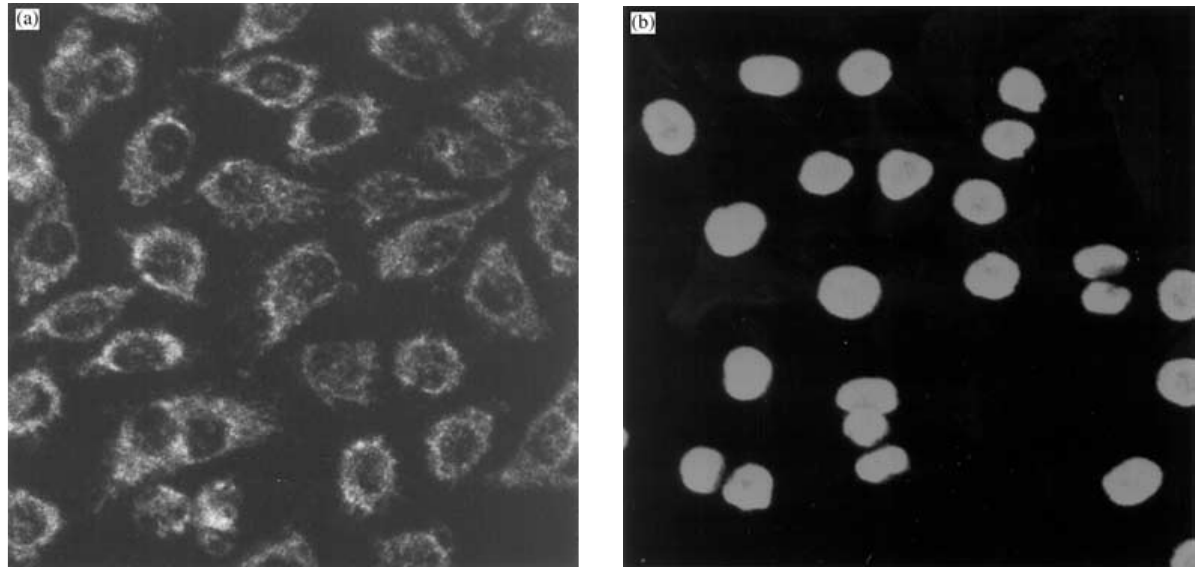
FIGURE 2 Sera isolated from SJL/J mice immunized with PDC-E2 demonstrate a speckled mitochondrial staining pattern. (a) Sera isolated from mice immunized with PDC-E2 diluted 1:40 showed a cytoplasmic speckled pattern corresponding to AMA. (b) Sera isolated from mice immunized with a -casein showed a fine staining pattern in the